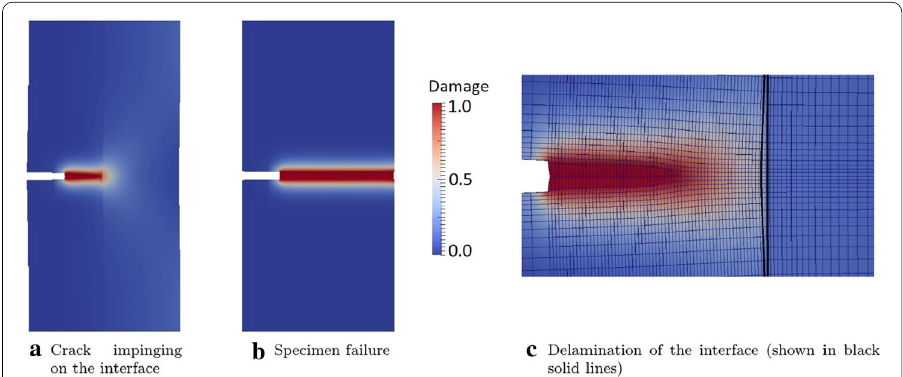
Fig. 12 a , b Two steps of crack propagation; c close-up view of delamination when the crack is approaching the interface (from [47])